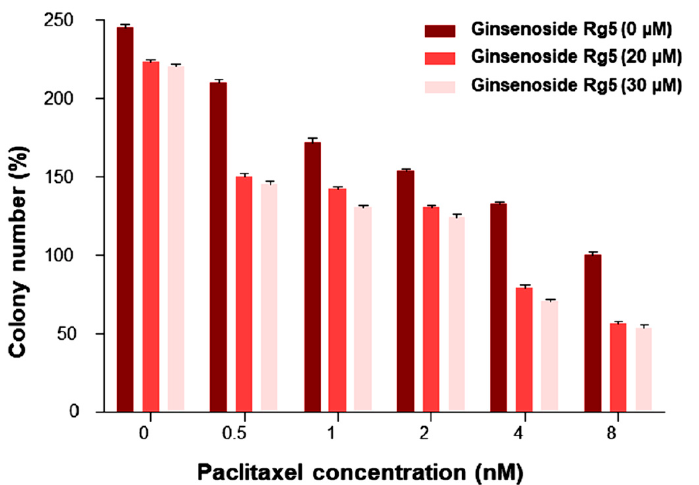
Figure 2. Colony Formation Assay: Representative bar diagram is the colony number data for HeLa-PTX-R cells treated with various concentrations of GRg5 (0, 20, and 30 µ M) combined with PTX (0, 0.5, 1, 2, 4, and 8 nM) to analyze the best synergetic combination. Each value is mean ± S.E.M of three individual experiments.